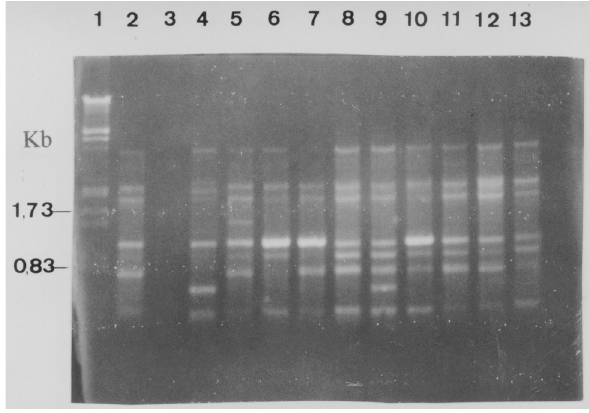
Figure 3 - Random amplified polymorphic DNA from 12 isolates of Drechslera tritici-repentis using primer B07. Lanes are as follows: (1) λ; Hind III- Eco RI; (2) CEP24-Selbach; (3) E24-Butiá Gr./Sertão; (4) E16- Selbach; (5) E16-Não-Me-ToqueII; (6) E16-Coxilha; (7) C19-Cruz Alta; (8) PF90120- Passo Fundo; (9) E16-Vacaria; (10) E16-Ronda Alta; (11) BR23-Santa Rosa; (12) E15-Lagoa Vermelha; (13) E16-Não-Me-ToqueI. The numbers on the left are the lengths of the marker bands in kilobases.